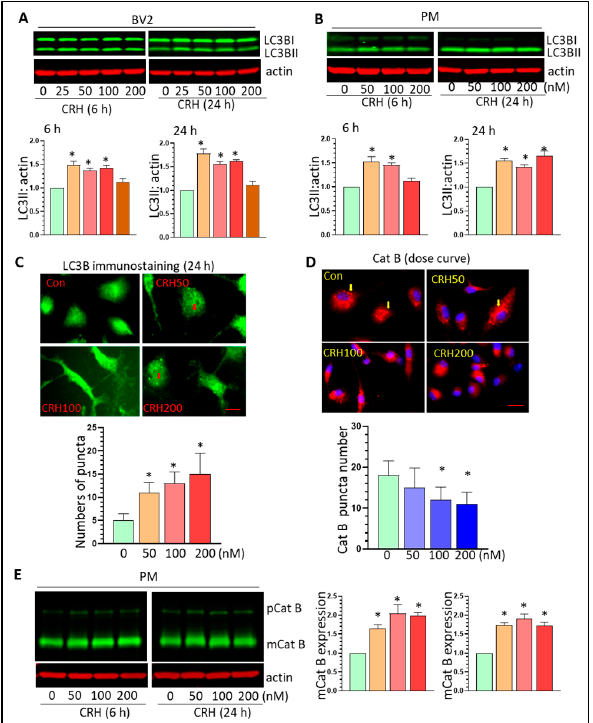
Figure 5. CRH increases autophagosome formation and induces Cat B leakage. ( A , B ): CRH increases LC3BII levels in BV2 cells and PM (* p < 0.05); ( C ): CRH increases autophagosome formation in PM (* p < 0.05, scale bar = 10 µ ); ( D ): CRH increases Cat B release in PM (* p < 0.05, scale bar = 10 µ ); ( E ): CRH increases mCat B levels in PM (* p < 0.05). All experiments were independently repeated at least three times for statistical